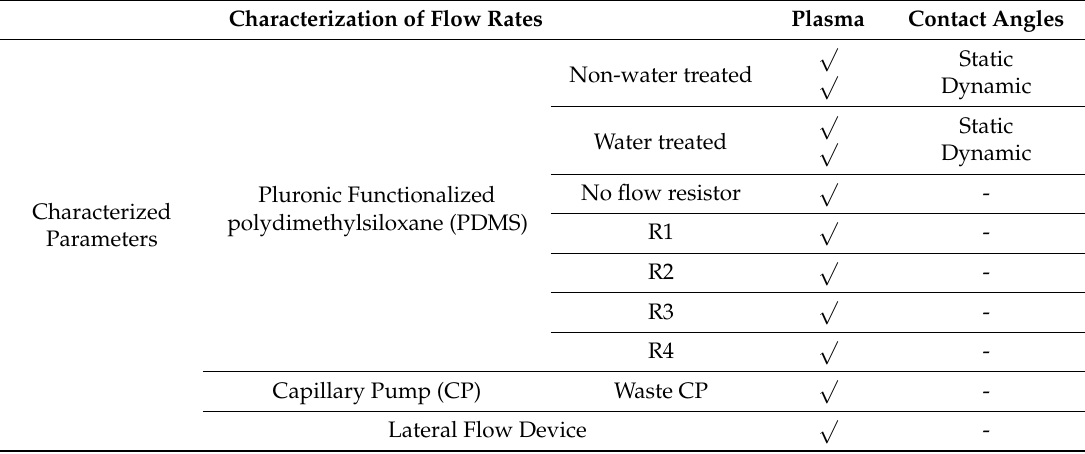
Table 2. Summary of measured parameters for characterization of flow